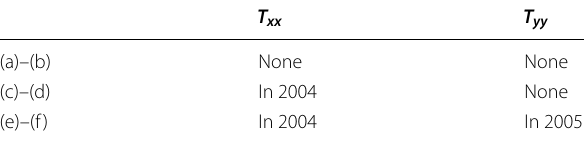
These three entries are selected based on criteria (1) and (2) mentioned above